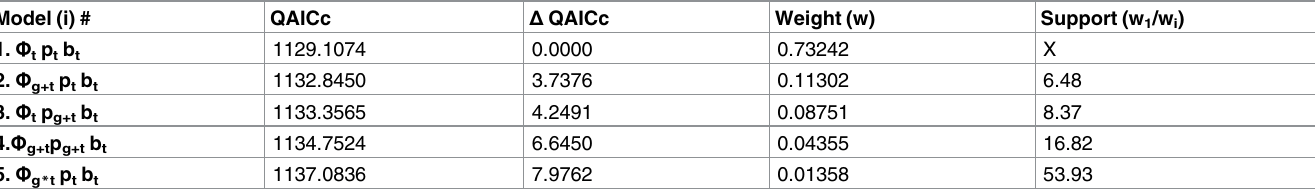
#. Φ = survival; p = probability of capture; b = probability of entry; t = parameter values vary in different capture occasions; g+t = additive model in which parameter values varied with gender and time; g * t = interaction between gender and